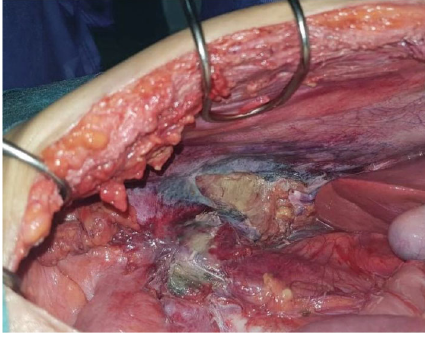
Figure 2: Operating view showing signs of retroperitoneal perforation after right colectomy.